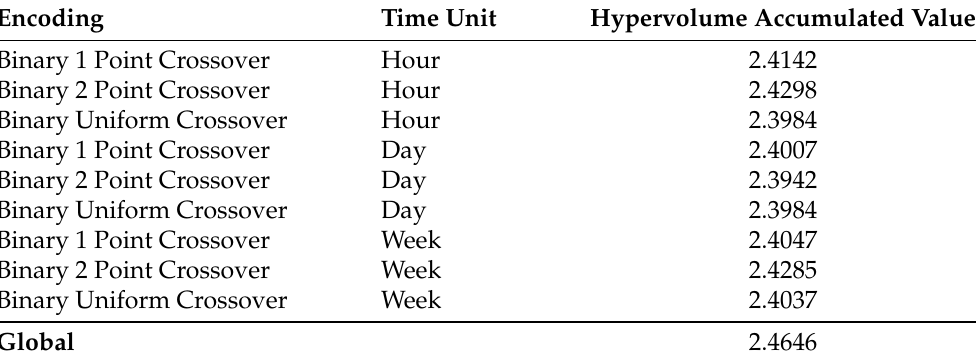
Table 14. Maximum accumulated Hypervolume value (accuracy experiment).